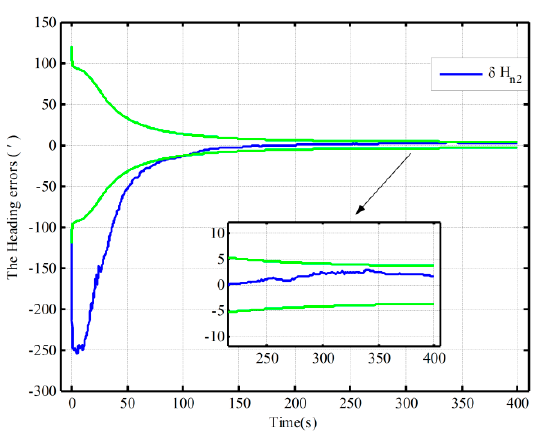
Figure 11. The alignment experiment s based on the closed-loop KF.